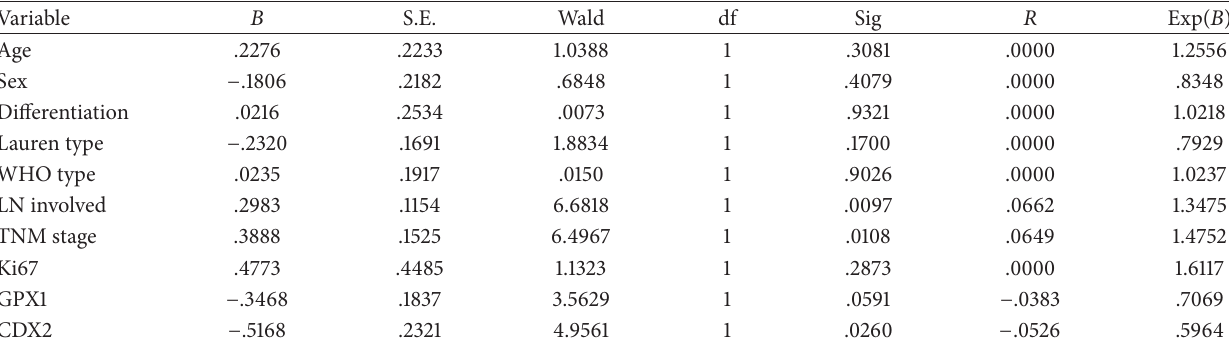
Table 2: Association of various factors with overall survival by logistic